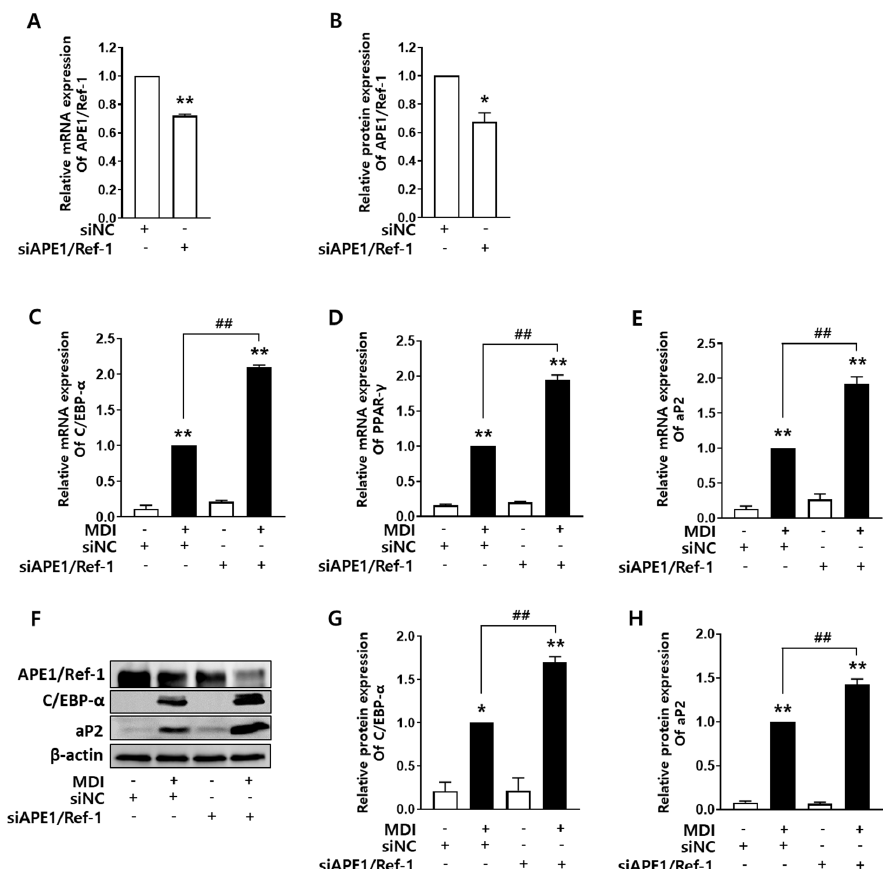
Figure 3. Silencing APE1/Ref-1 using siRNA (siAPE1/Ref-1) increased adipocyte differentiation of 3T3-L1 cells. ( A , B ) APE1/Ref-1 silencing in 3T3-L1 cells decreased the mRNA and protein levels